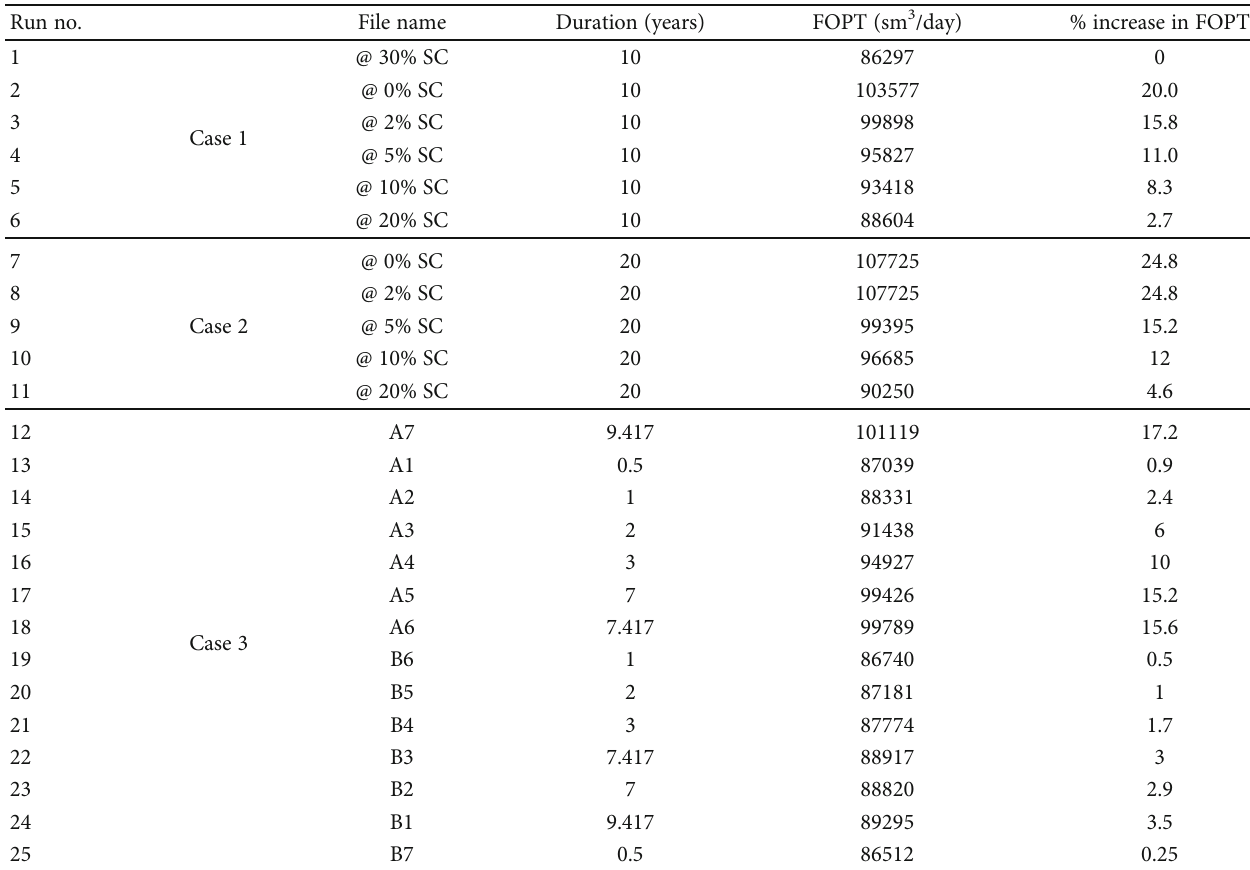
Table 8: FOPT for all